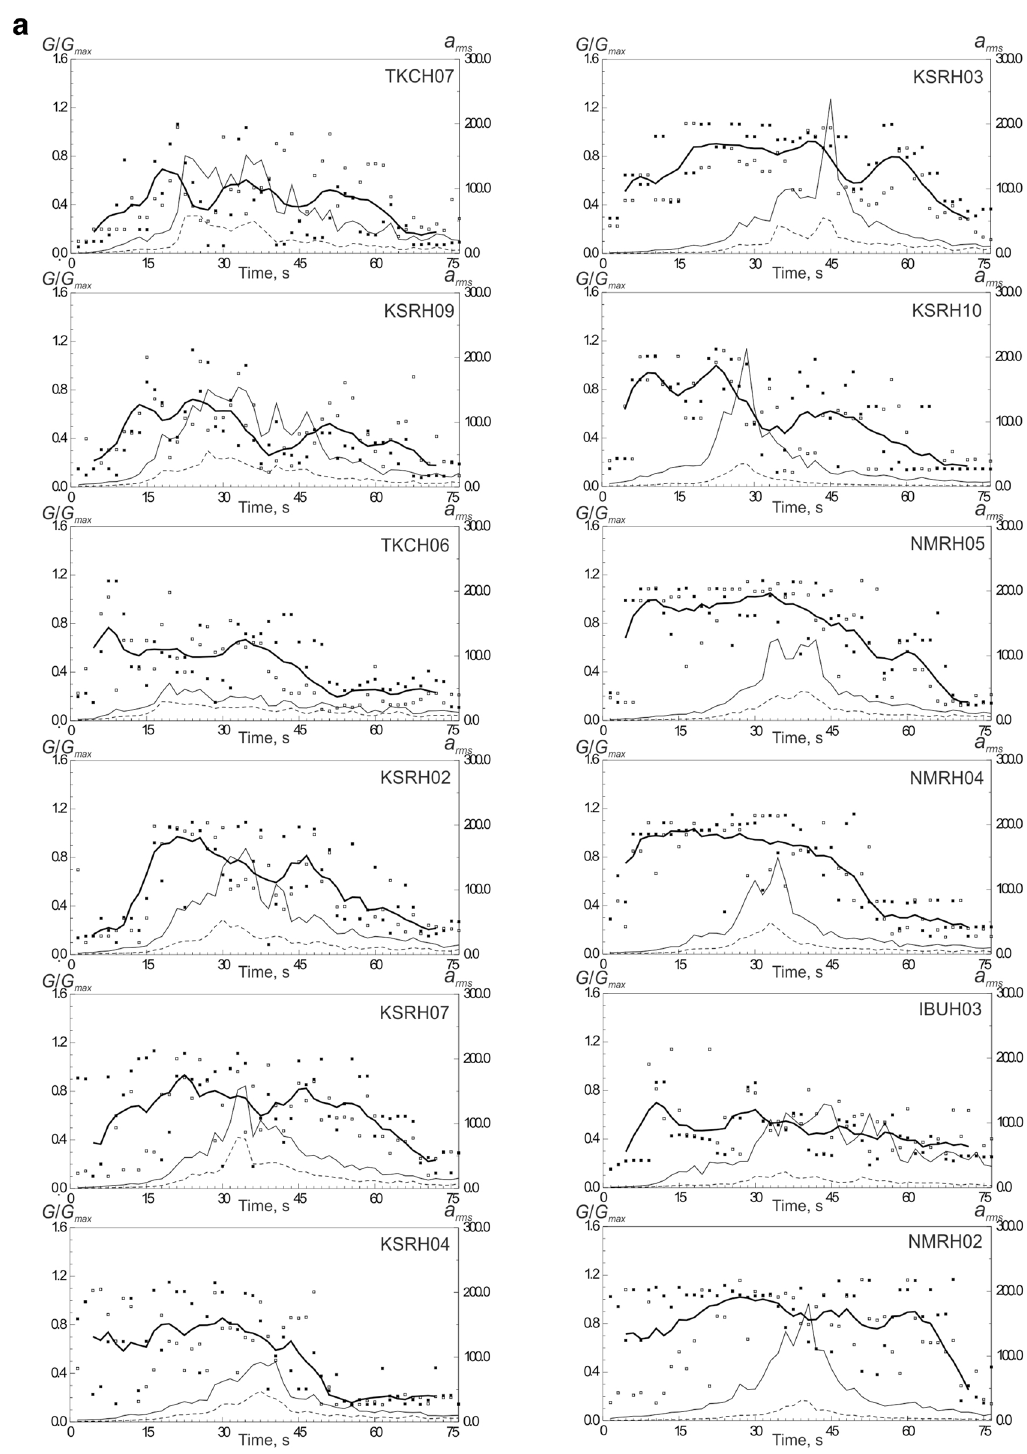
Figure 3. Changes of shear moduli in soil layers at the studied KiK-net sites during the Tokachi-oki earthquake (75 s of strong motion): ( a ) at sites with softer subsurface soils, ( b ) at sites with denser subsurface soils. Points indicate estimated shear moduli in successive time intervals at two horizontal components (white and black points mark EW and NS components), and thick lines show these values smoothed and averaged over two horizontal components. Thin lines are the intensities of motion on the surface (solid lines) and at depths of locations of deep devices (dash